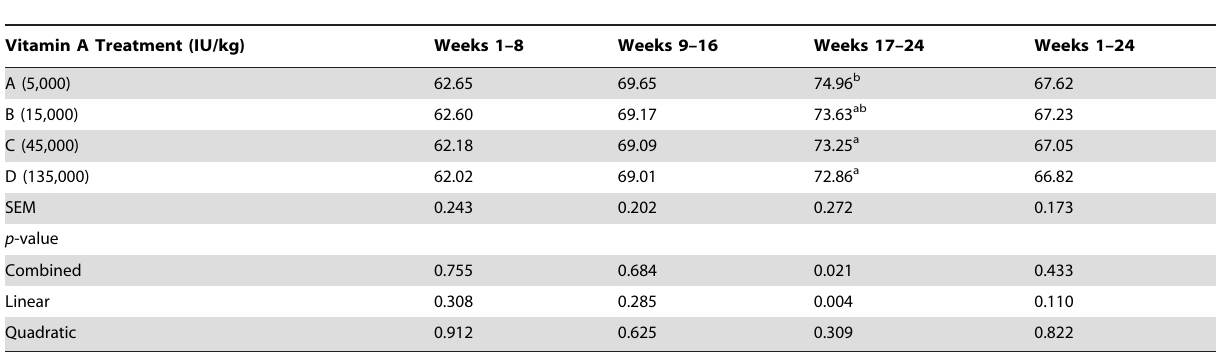
Table 3. Average weight of normal